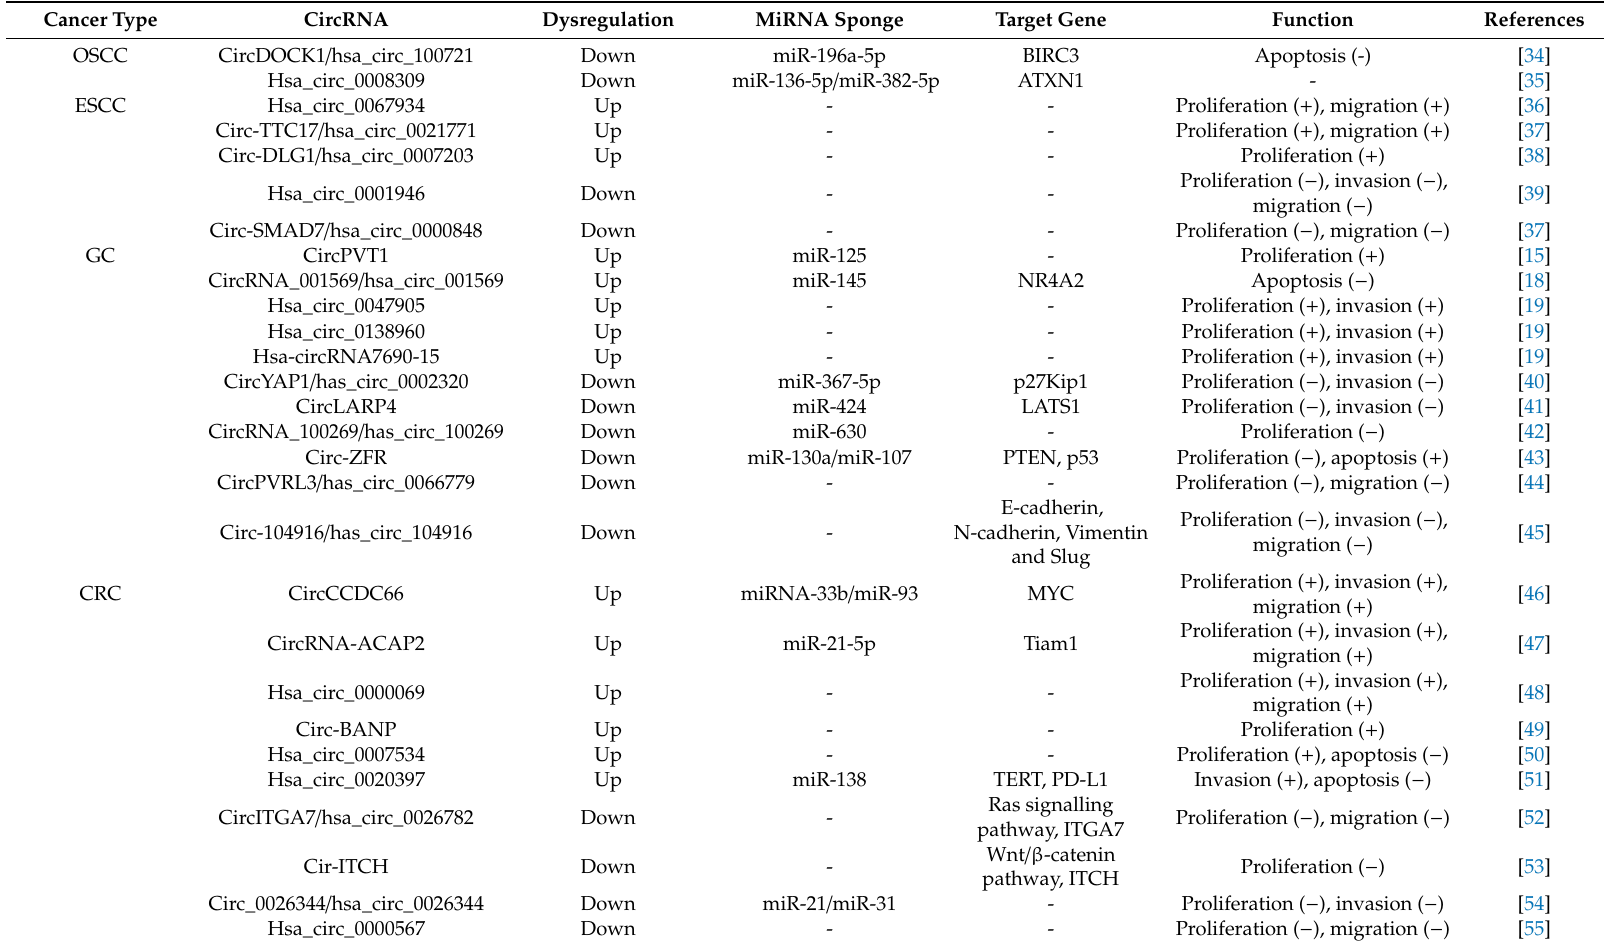
Table 2. CircRNAs in digestive tract